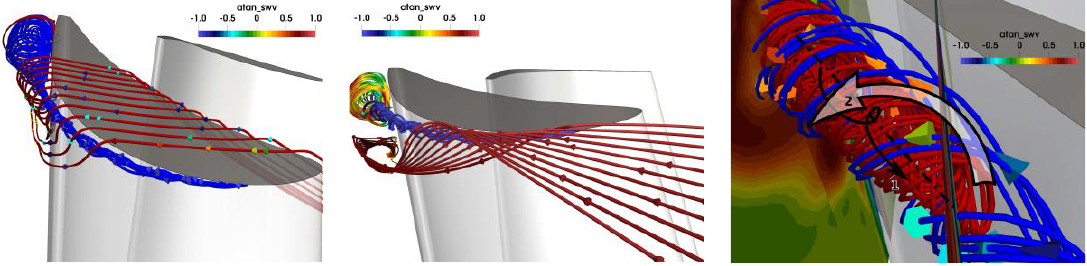
Figure 7. Streamlines in the tip region (not colored by SWV). The effect of the described secondary flows can be clearly seen in the wall streamlines based on the wall shear stress on the rotor blade in Figure 9. On the pressure side, the flow moved towards the hub, driven by the lower channel vortex. In the tip region, there was a strong radial movement caused by the common effect of upper passage vortex and tip leakage flow. On the suction side, there was a distinct movement towards mid-span at hub and shroud. In the tip region, the limit streamline separated the counter-rotating tip leakage vortex and the upper channel vortex, as described above. A similar strong radial movement was found in the hub region. The small zone of low wall shear at mid-span indicated flow separation caused by the impinging shock there. Additional small backflow regions were found at the hub and